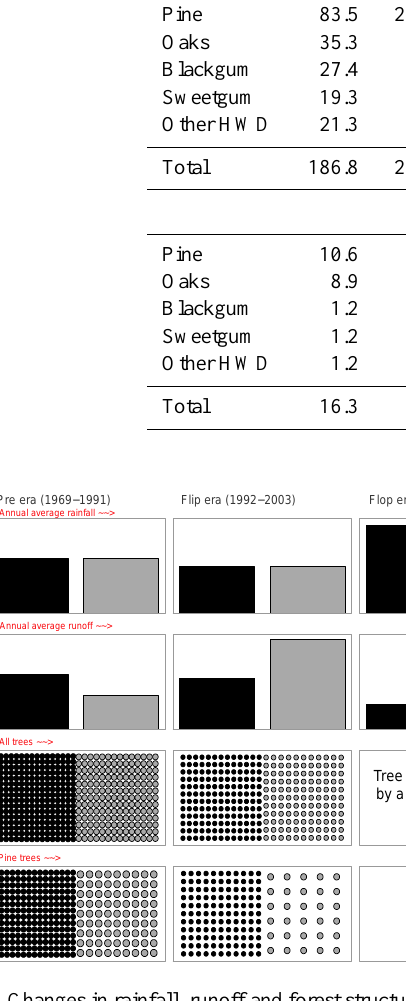
Fig. 6. Mean monthly flow differences between WS77 and WS80 from 1969–2011. No records were collected from 1982 to Sept. 1989. Listed treatments were applied only in WS77.